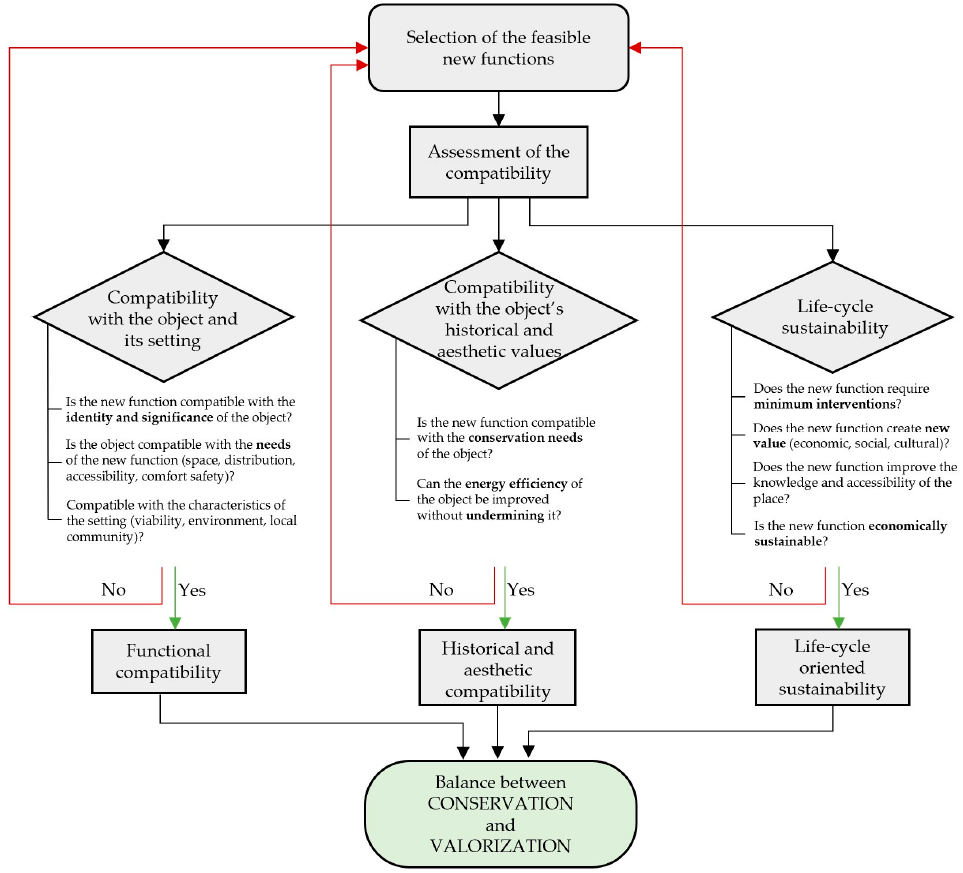
Figure 1. The three levels of compatibility in the process of selecting the feasible new functions.